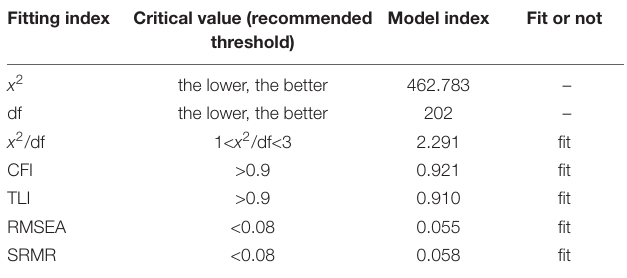
TABLE 3 | Fitting indexes of structural equation